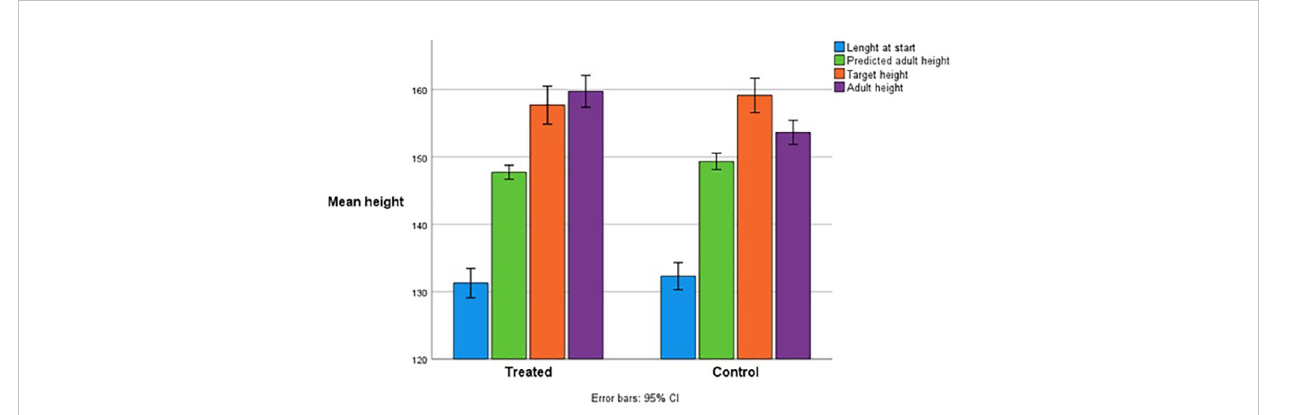
FIGURE 3 Adult height compared with predicted adult height and target height in the treated and control patient